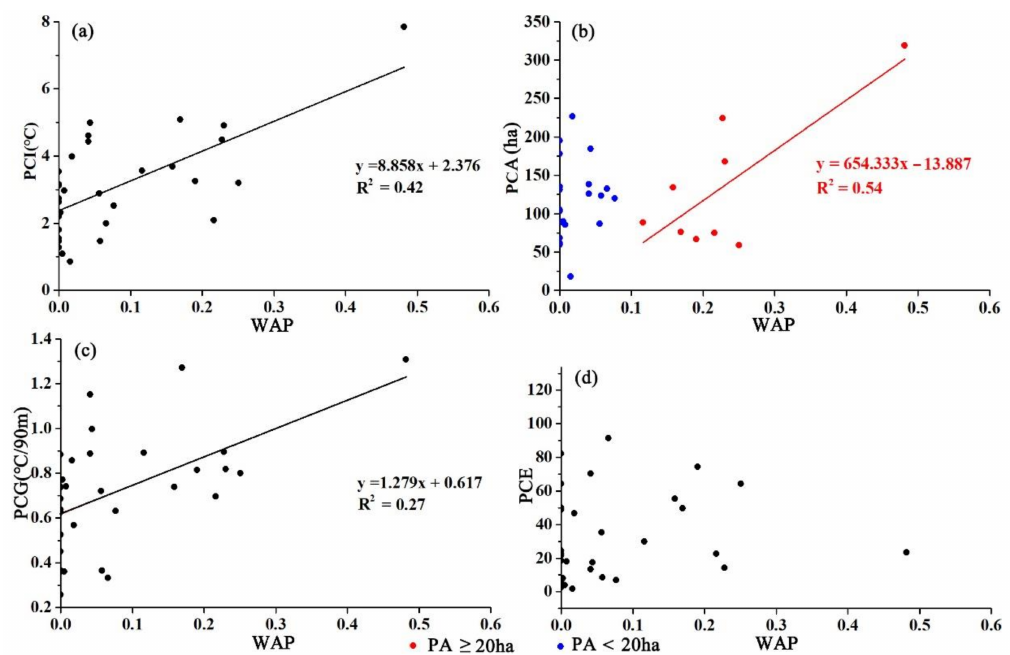
Figure 9. Linear regression models of the WAP and ( a ) PCI, ( b ) PCA, ( c ) PCG, and ( d )